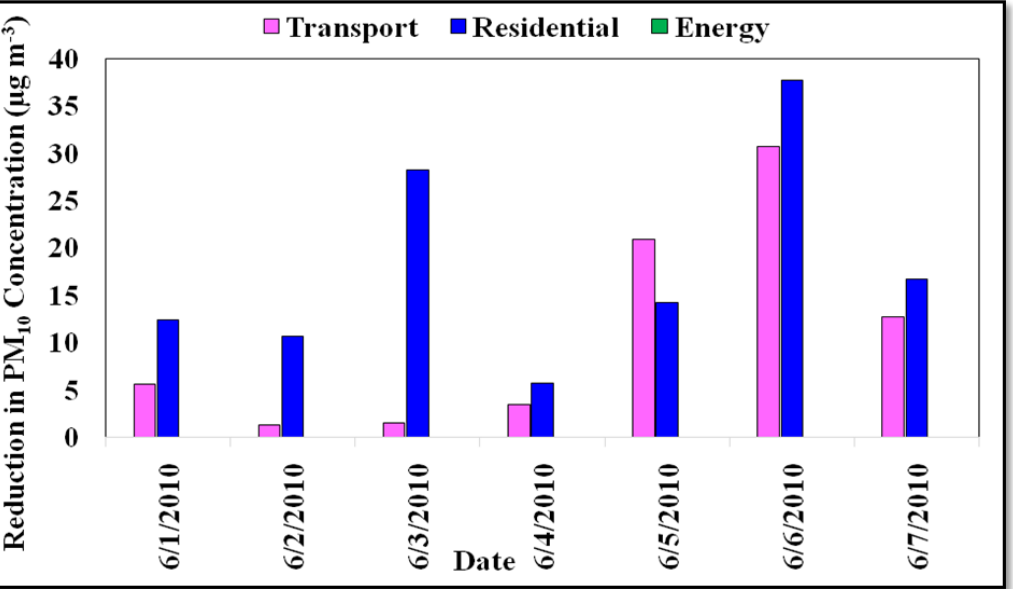
Figure 3. Reduction plots of simulated PM 10 concentrations (µg m −3 ) representing the difference between original and proposed emission scenarios for transport (pink), residential (blue), and energy (green) sectors, averaged for the entire simulation period over the Delhi domain. Note: No change in concentration was noted in the energy sector.